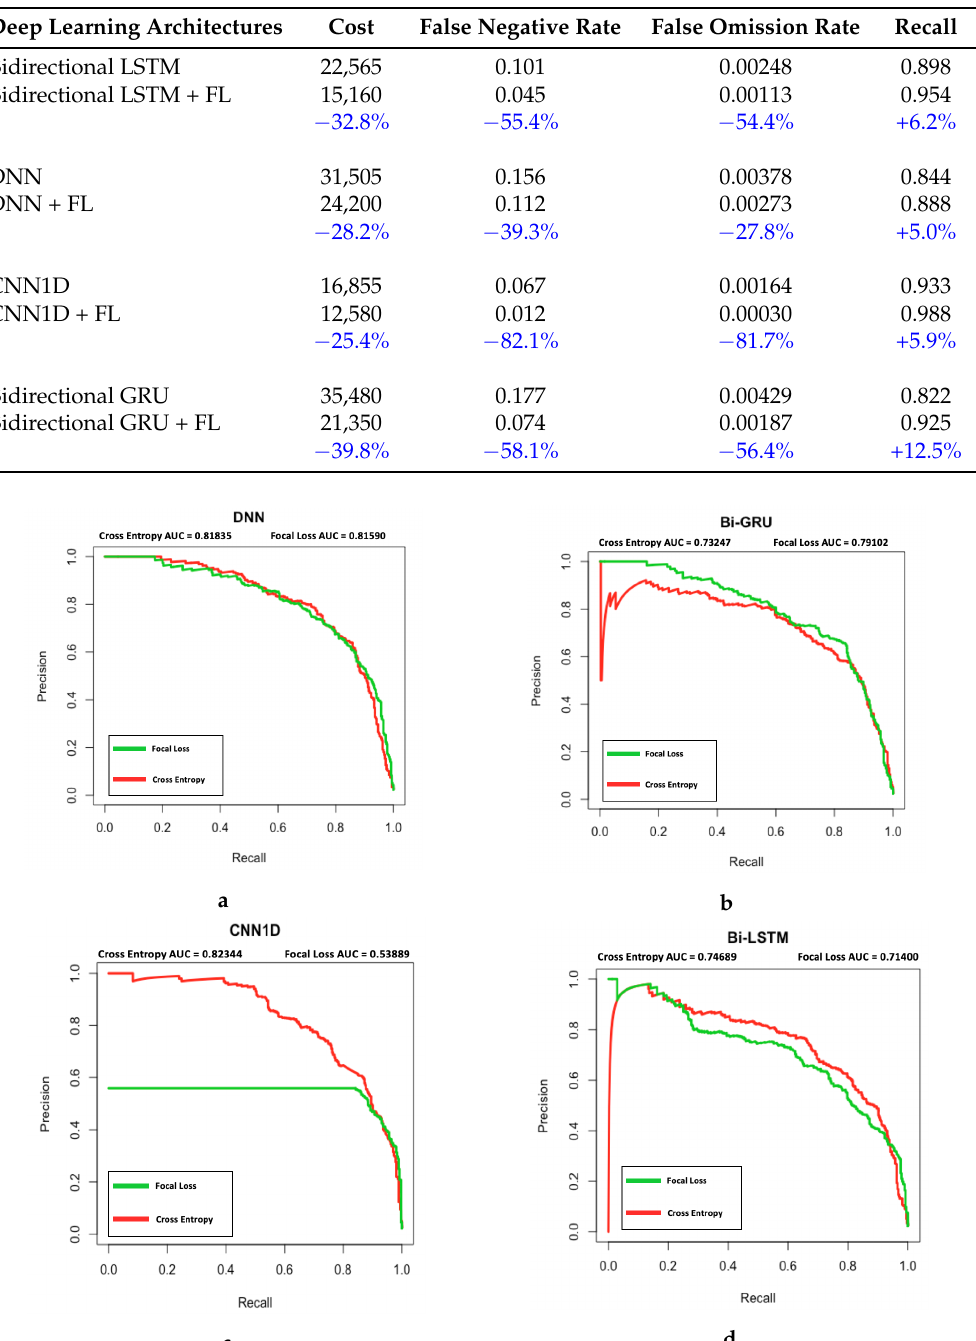
Figure 14. PR Curve for ( a ) DNN, ( b ) Bi-GRU, ( c ) CNN1D, and ( d ) Bi-LSTM using focal loss (Green line) vs. cross entropy loss (Red line). The AUC of PR curves are included at the top of each plot for each loss